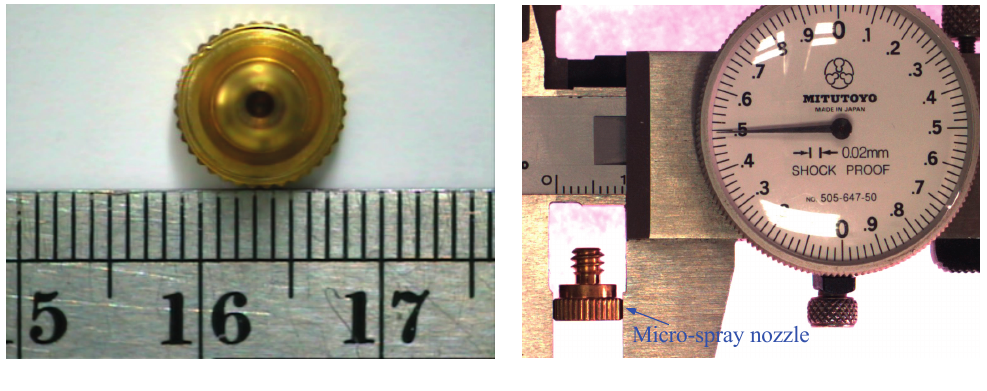
Figure 1. Micro-spray nozzle.